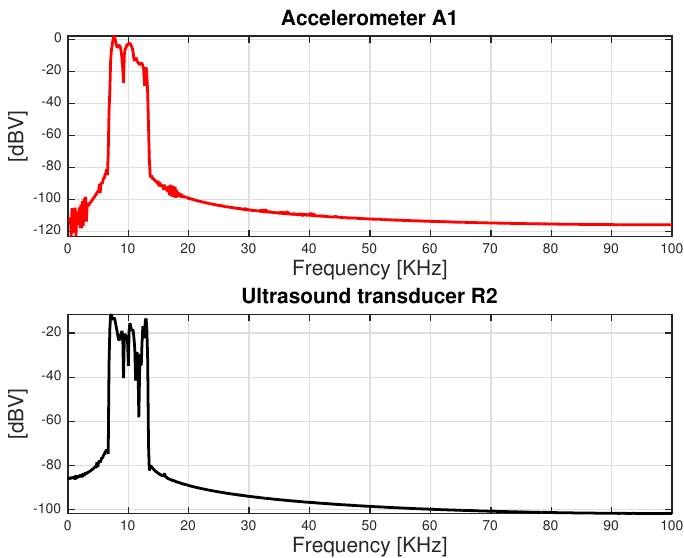
Figure 8. Sensors recordings spectra in passive configuration, 1 buffer triggered by A1: accelerometer A1 ( up ) and ultrasound transducer R2 ( down